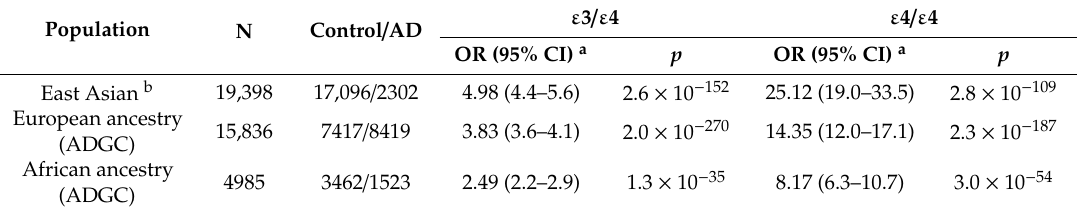
Table 1. Association of APOE ε 4 with Alzheimer’s disease among East Asian, European ancestry, and African American